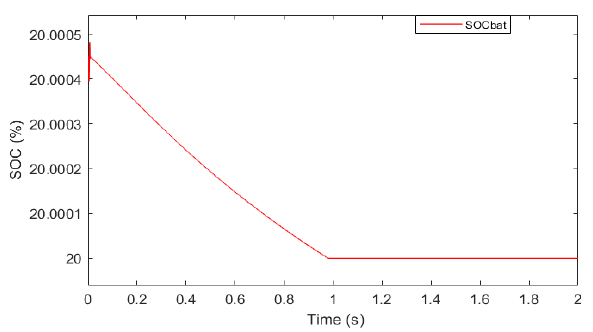
Figure 21. Battery SOC in DPM.